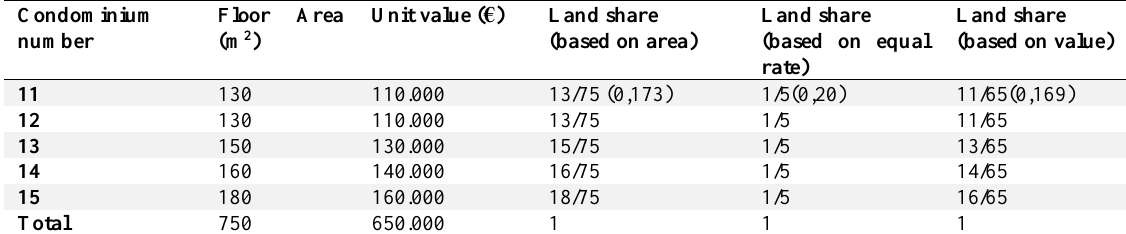
Table 1. Determination of the land shares with different